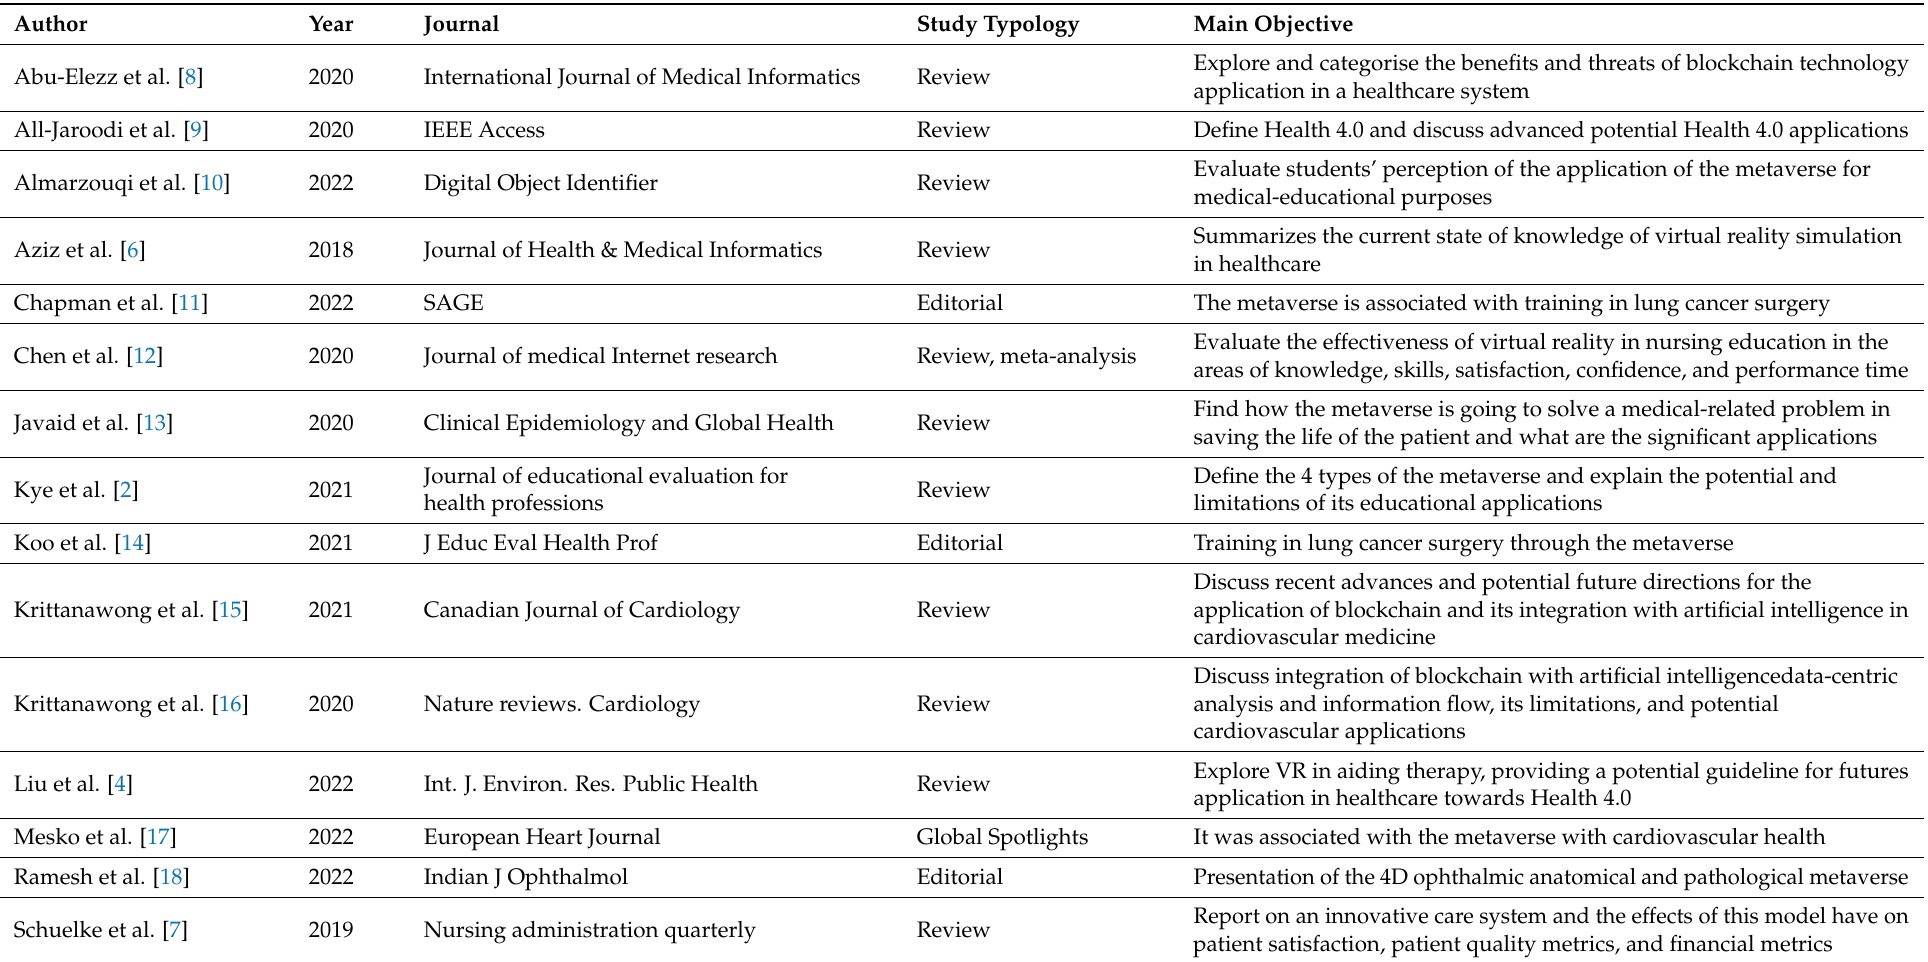
Table 1. Characteristics of the included